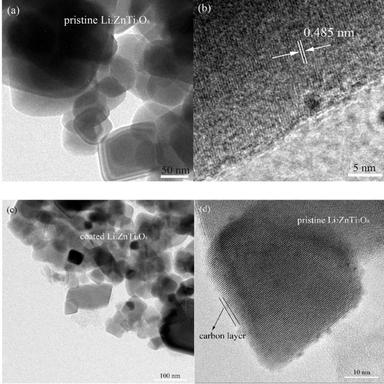
TEM and HRTEM images of pristine LZTO (a, b) and LZTO/C-3 (c, d) particles.